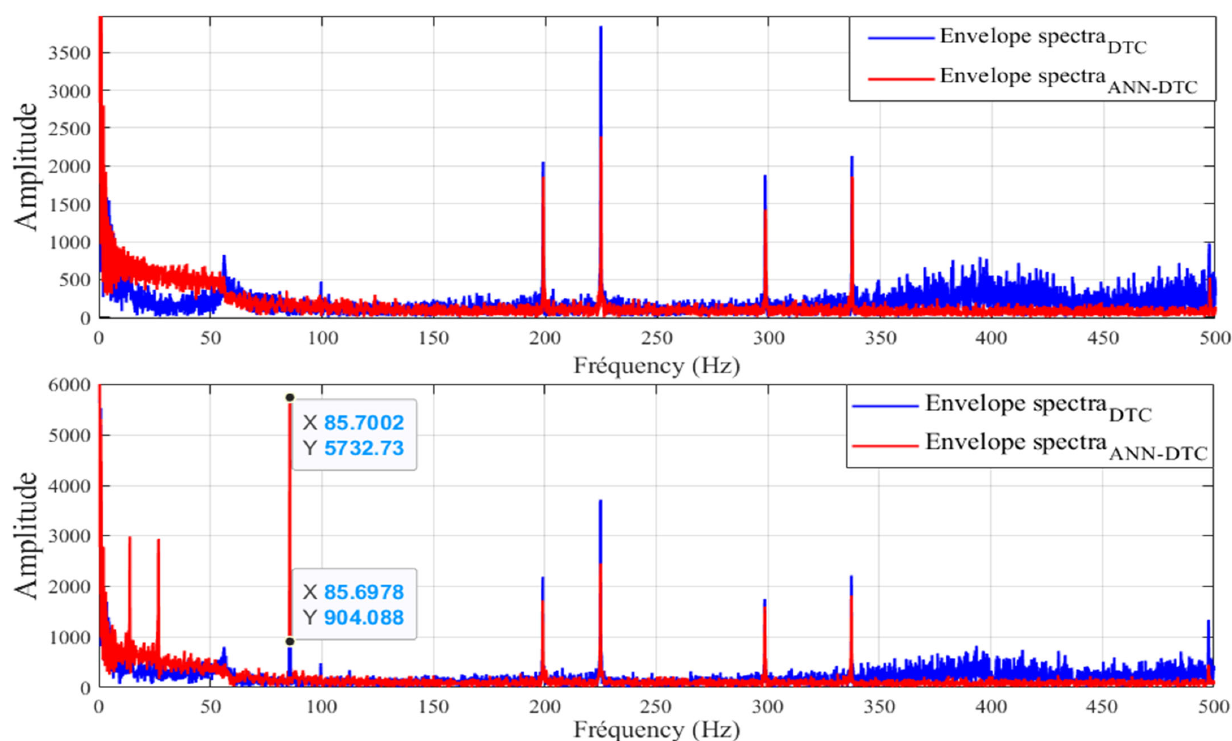
Figure 37. Comparison of IM current envelope spectra controlled by DTC and ANN ‐ DTC: Healthy State ( top ) , with GOLD defect ( Bottom ).